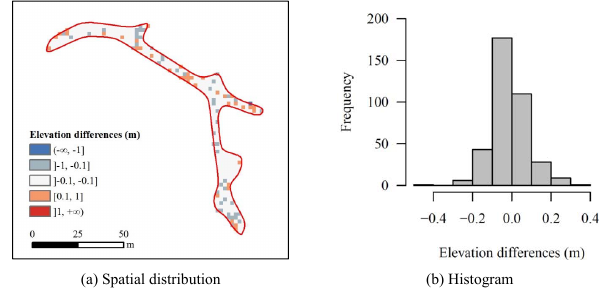
Figure 8. Elevation differences between the UAV DEM and the li- dar DEM (both with 2mpixel − 1 resolution).